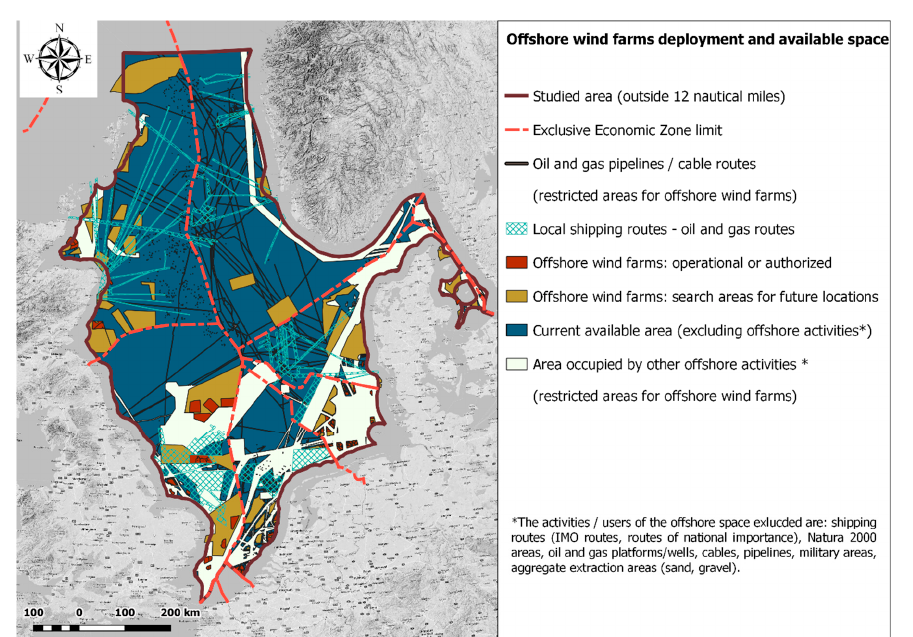
Figure 4. Available space offshore when excluding existing activities/spatial claims for different offshore activities.